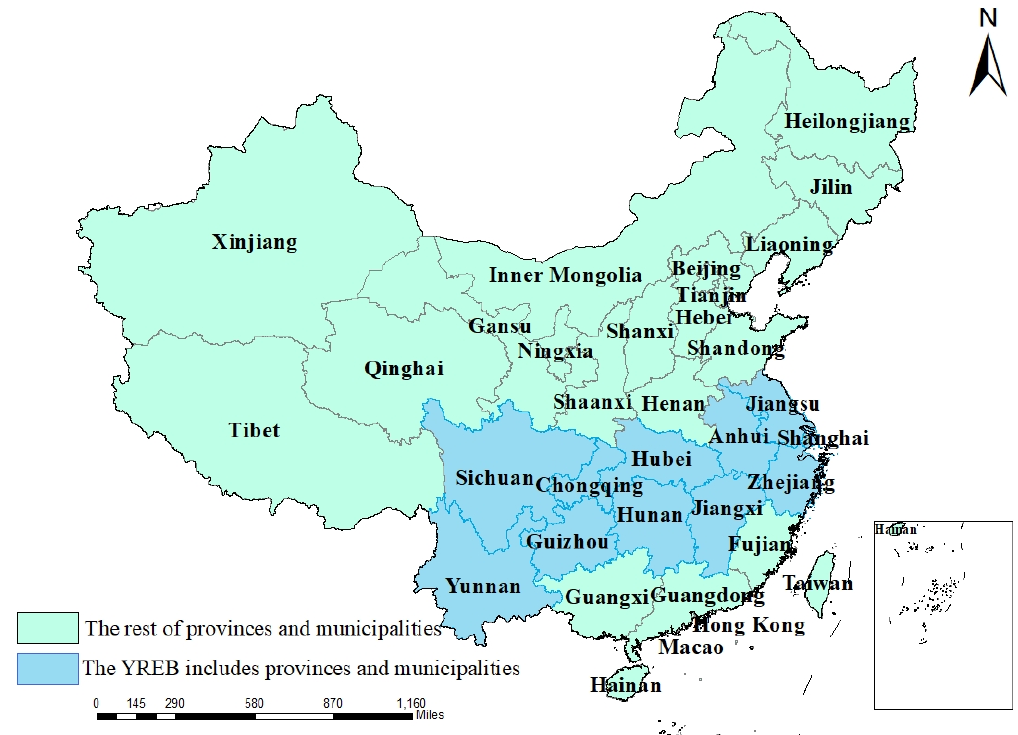
Figure 1. Map of China with light green shading indicating the non-YREB provinces/cities and h light blue indicating the YREB provinces/cities.